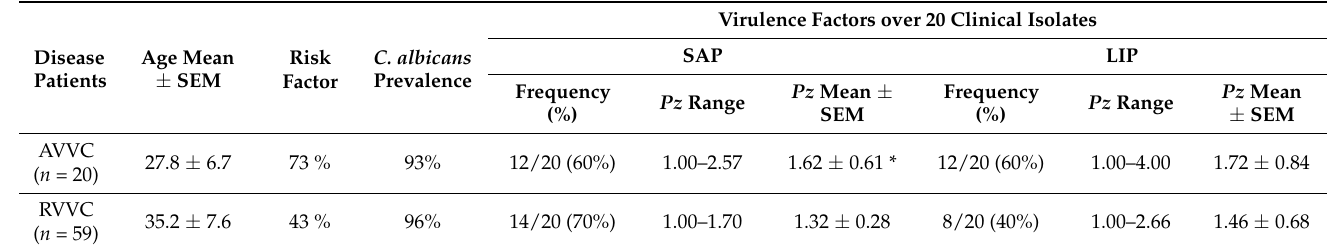
Table 1. Some characteristics of patients and virulence factors of clinical